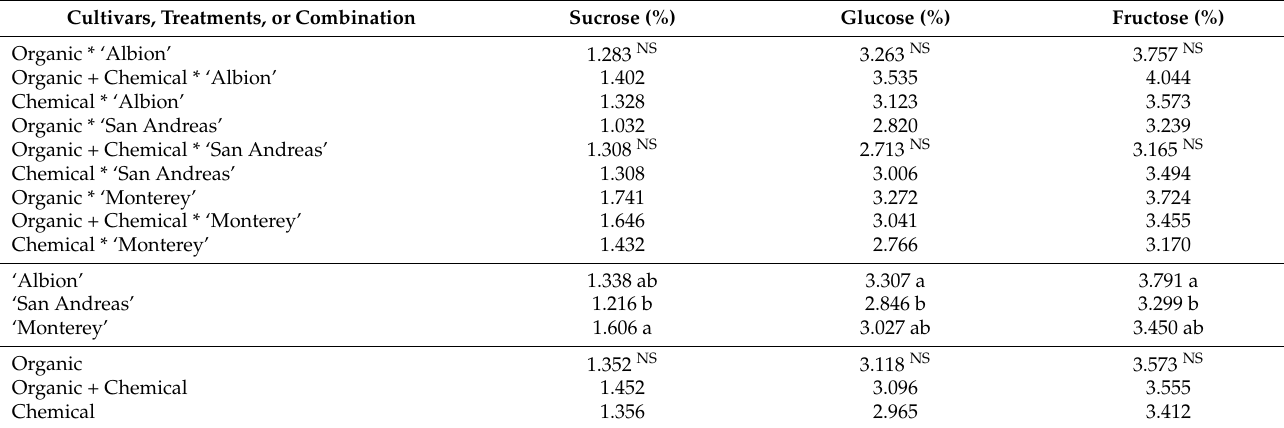
Table 5. The sugar content of strawberry fruits is affected by different fertilizer